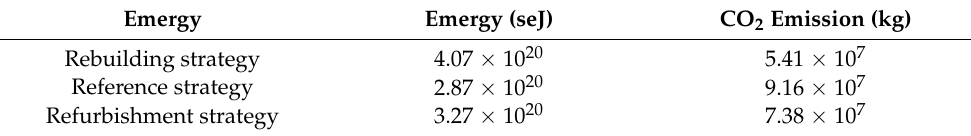
Table 8. Total emergy and total CO 2 emissions in the three